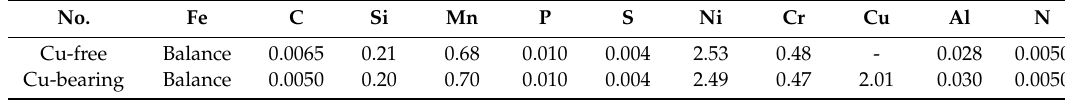
Table 1. Chemical composition of the tested steels (in mass%).